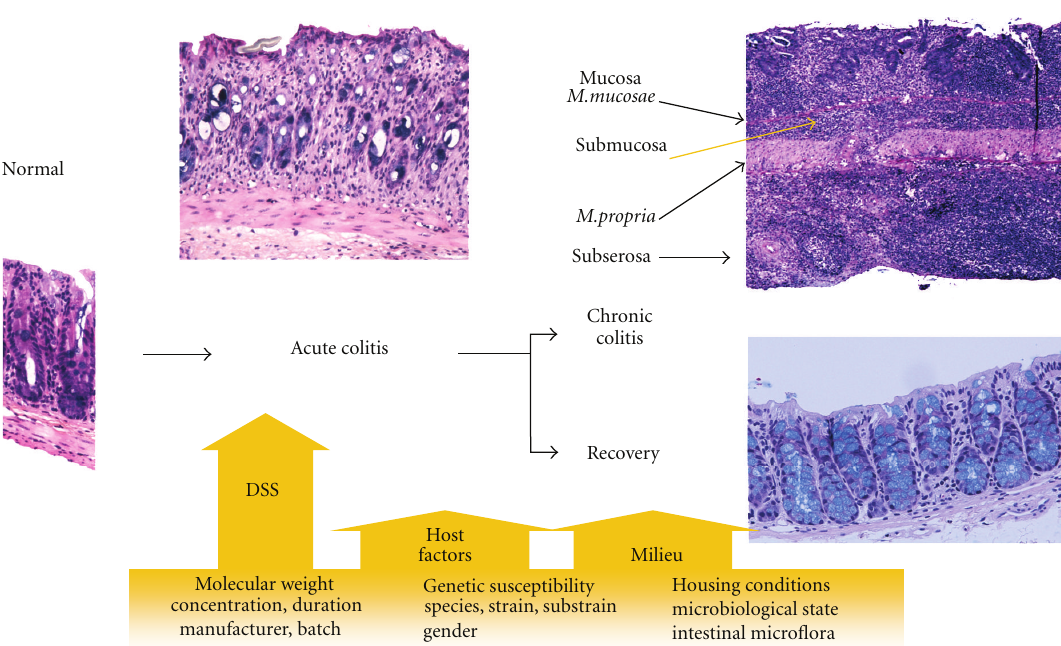
Figure 1: Schematic simplified representation of various factors that can influence the susceptibility, onset, severity, and responsiveness to DSS-induced